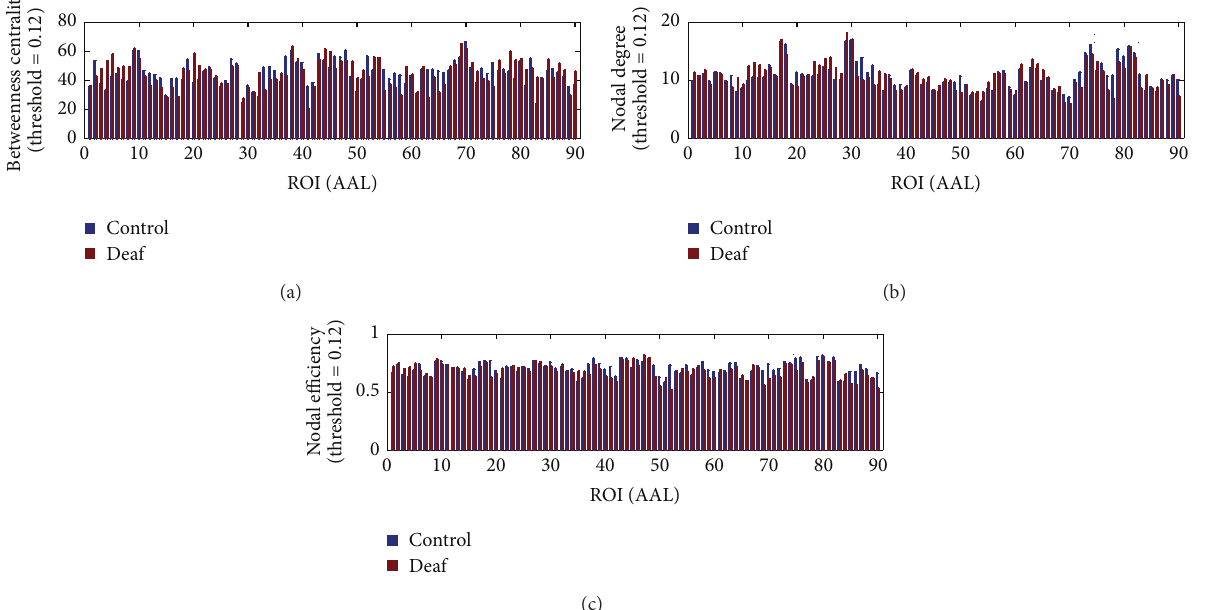
Figure 5: Bar plots for the average value for regional topological properties of 90 ROIs, including betweenness centrality (a), nodal degree (b), and nodal efficiency (c), in control and deaf groups. The blue color indicates the control group, and the red color represents the deaf group.